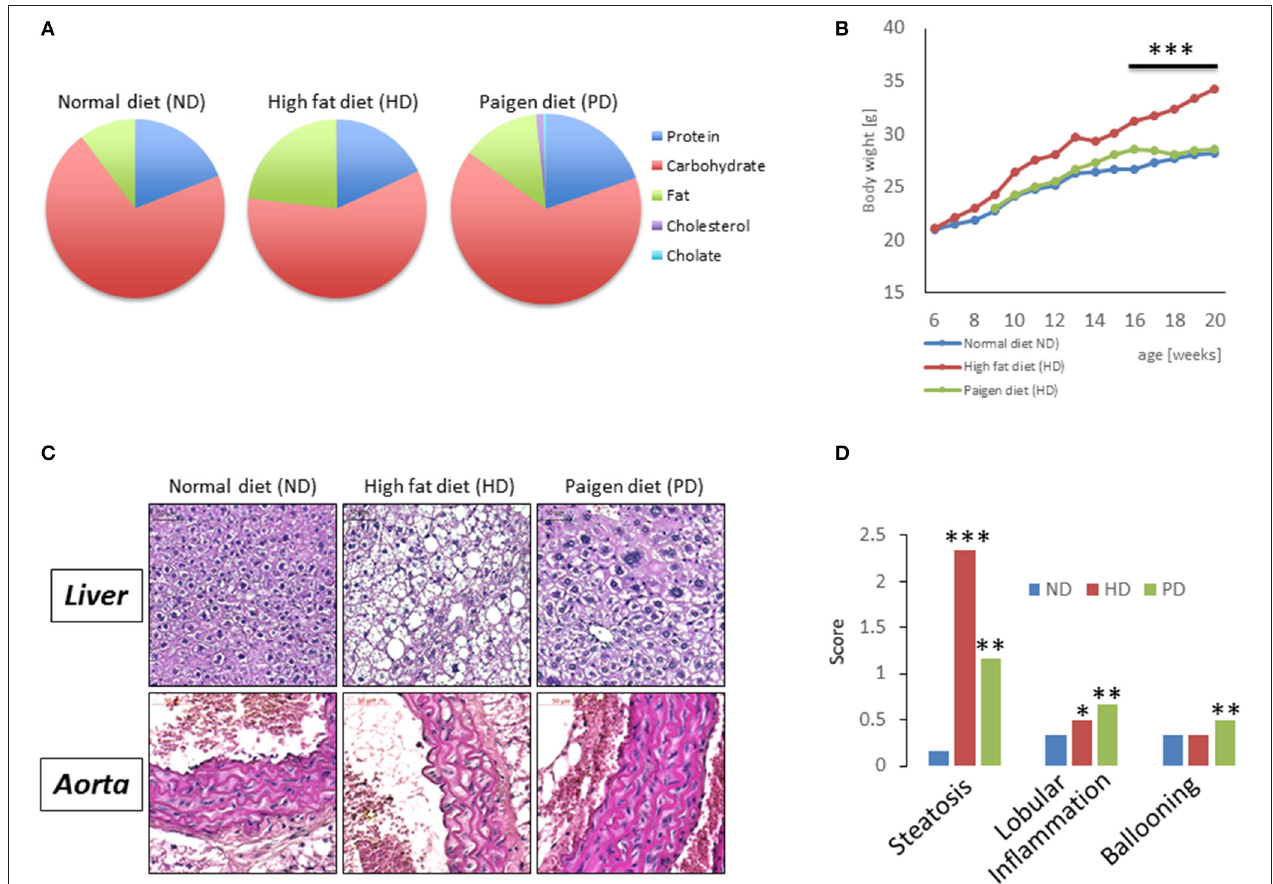
FIGURE 1 | (A) Pie chart representing diet compositions in terms of fat, carbohydrates, choline, cholesterol, proteins. (B) Body weight of C57/BL6 mice fed for 20 weeks with a normal chow diet (ND), high fat diet (HD), or Paigen diet (PD). (C) Representative pictures from hematoxylin and eosin staining of liver sections (upper panels) and aorta sections (lower panels) in C57/BL6 mice fed with ND, HD, or PD. (D) Steatosis, lobular inflammation, and ballooning were scored semi quantitatively (0–4). * p < 0.05; ** p < 0.01; *** p < 0.001 vs.